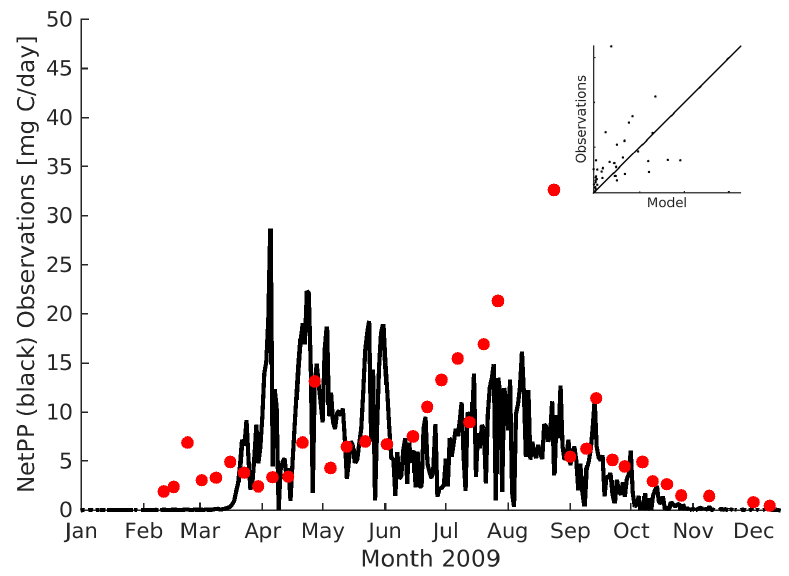
Figure 5. Evolution at 10 m of total phytoplankton net production. The observations correspond to the red dots while the model is the solid line. The one to one plot between observations and model results is included as a thumbnail to illustrate the correspondence between the